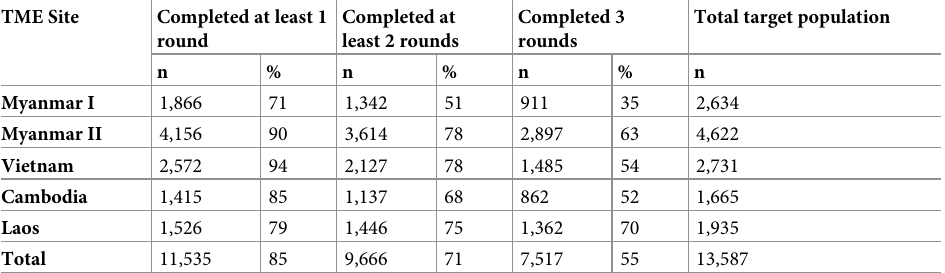
Table 2. Coverage of MDA at the TME